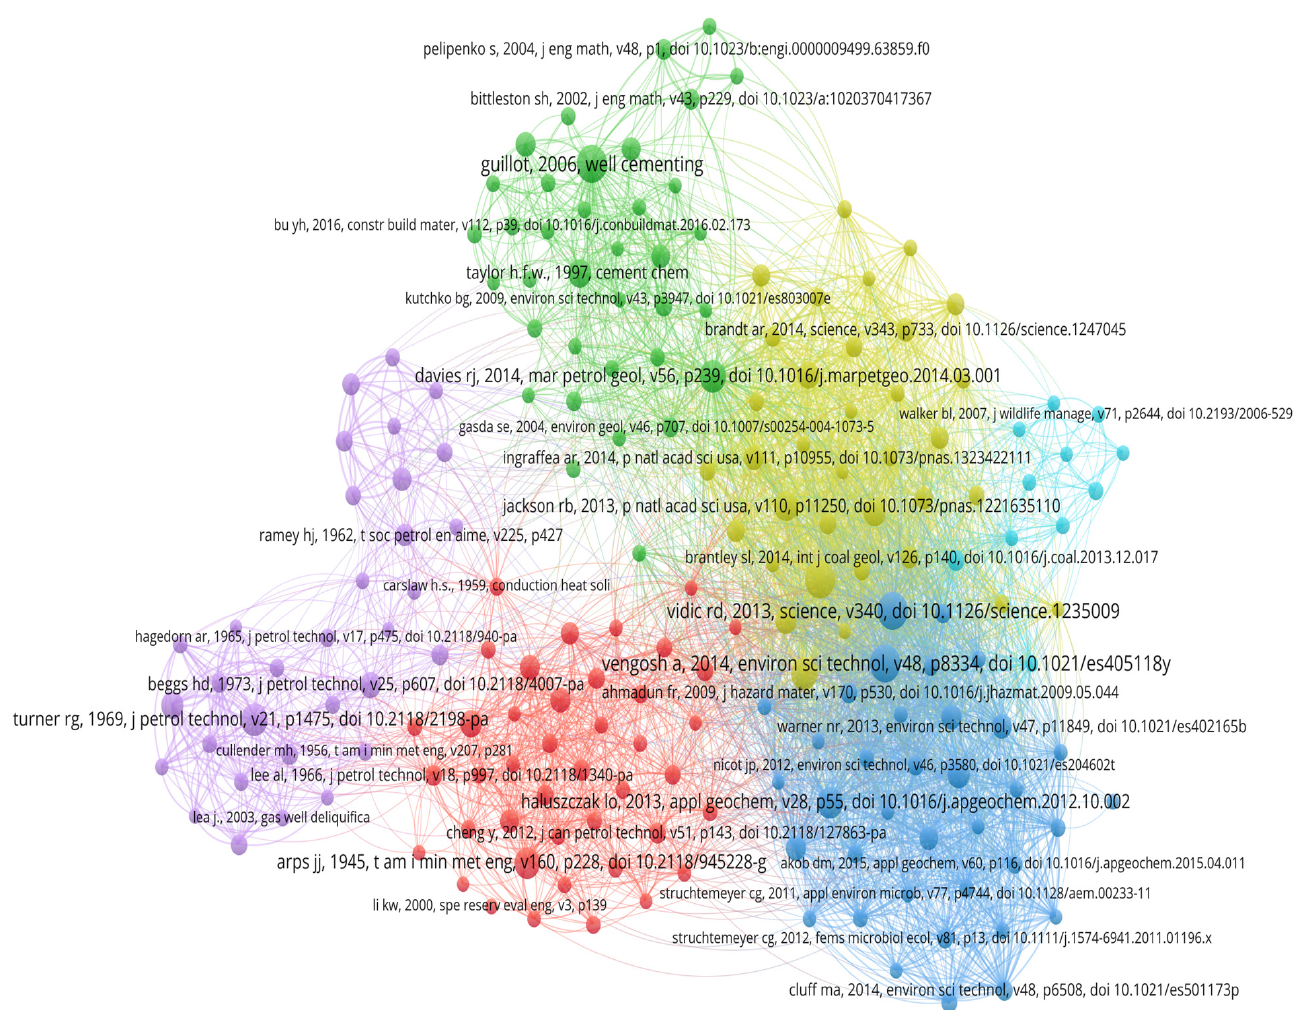
Figure 5. Literature co-citation network of oil and gas well research published between 1900 and 2021.